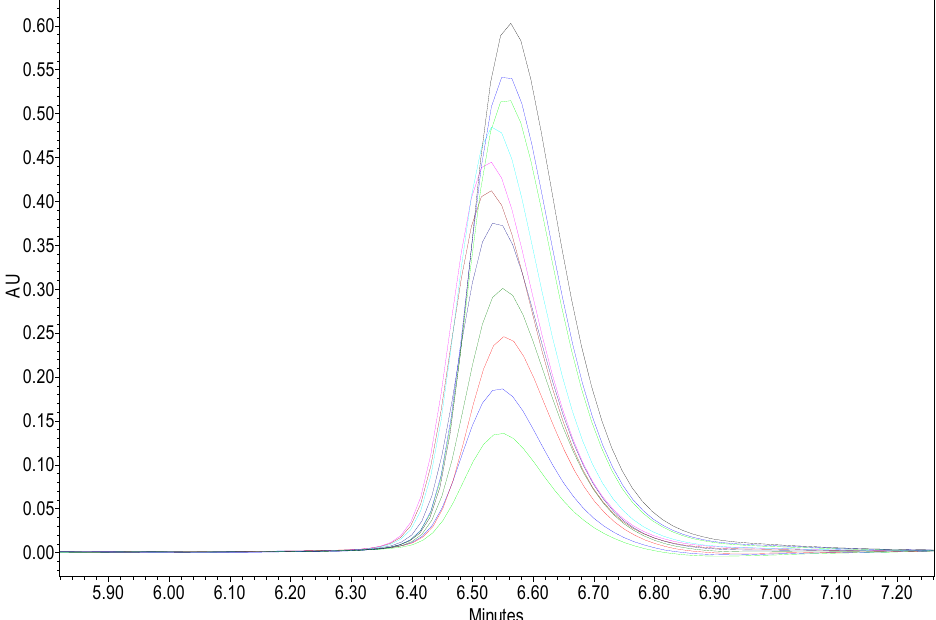
Table 2. TOC removal in the presence of Zn4La400 (500 mg / L) catalyst after 180 min of UV-A irradiation. Pollutant Concentration, (mg / L) TOC Removal,